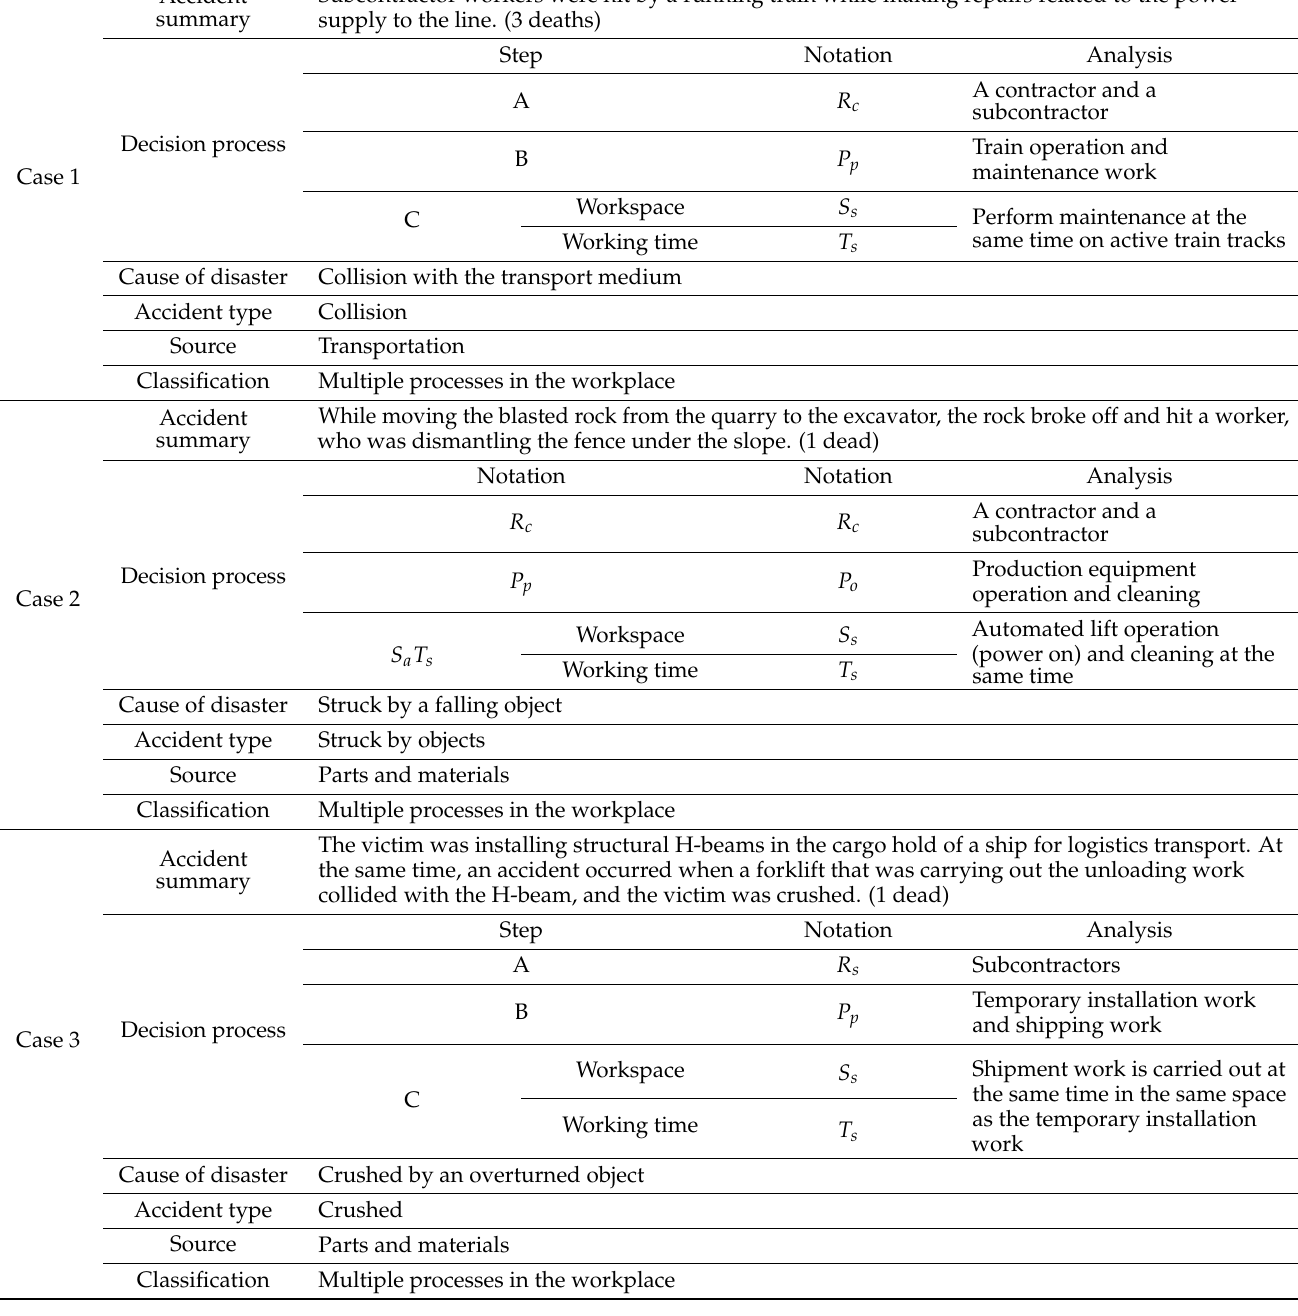
Table 5. Representative actual cases of the accident caused by multiple processes in the workplace— Service and